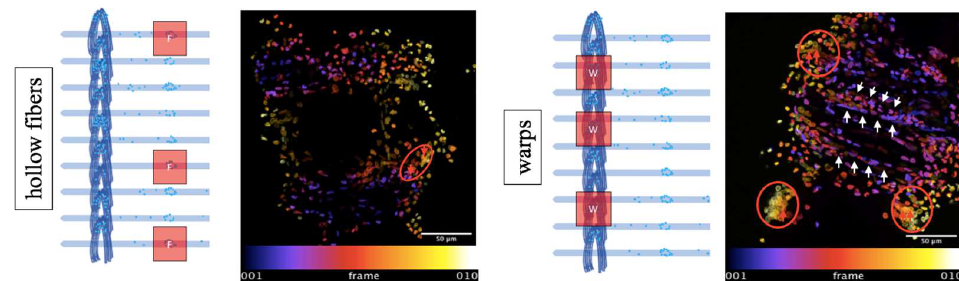
Figure 2. Representation of the different morphologies of cell deposits in the area of the hollow fiber and junctions of cross-linking warp threads on ECMO membranes. The representation is in temporal color code, which translates into spatial resolution. Cells from lower levels are marked in bluish hues and cells from higher levels in yellow. Z-range fiber ( left panel ) 56, 91 µm, distances between z-planes: ~5, 6 µm. Z-range warp ( right panel ): 42, 48 µm, distances between z-planes: ~4,2 µm. F = predilection sites on fibers. W = predilection sites on warp stitches. Deposits on the warps of the oxygenator had a spatially superimposed shape with cell clusters (red arrows in red circles, right panel) and strand-like aggregates (white arrows, right panel ). Deposits on the hollow fibers also showed a spatial overlay and close spatial proximity (red arrows in red circle, left panel ).